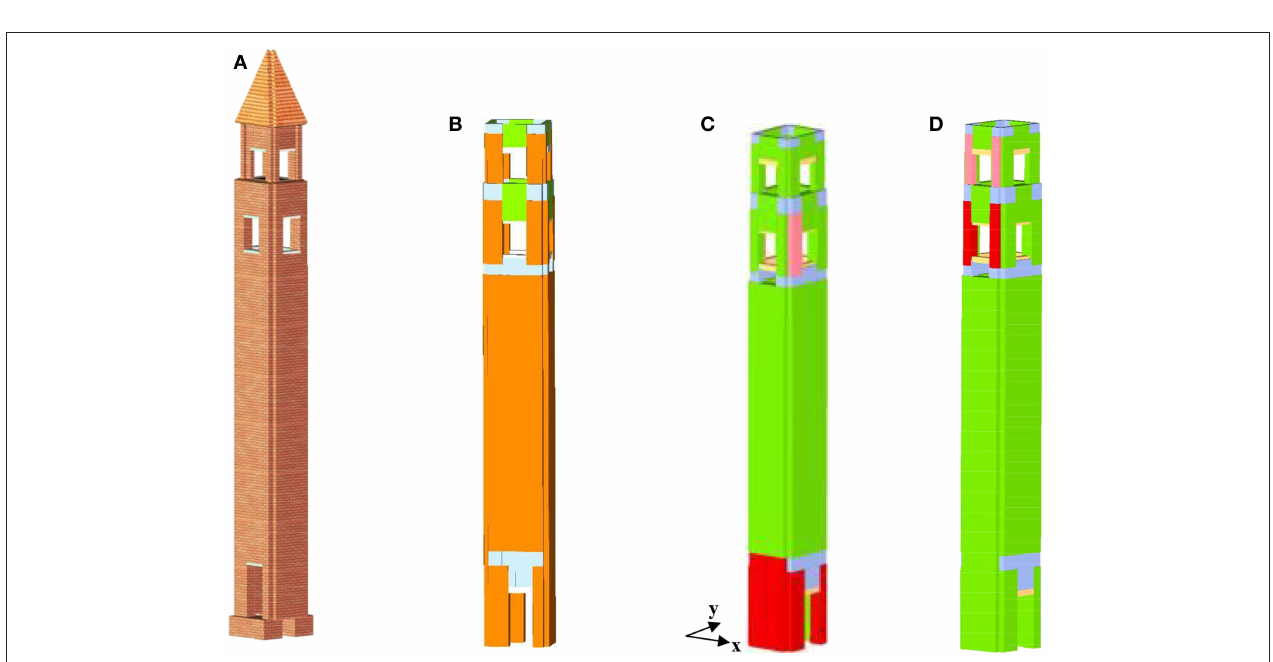
FIGURE 5 | The isolate tower: architectural layout (A) , FME model (B) and deformed shapes (pink: bending-compression plastic; red: bending-compression failure) from pushover analyses in the directions x (C) and y (D) .